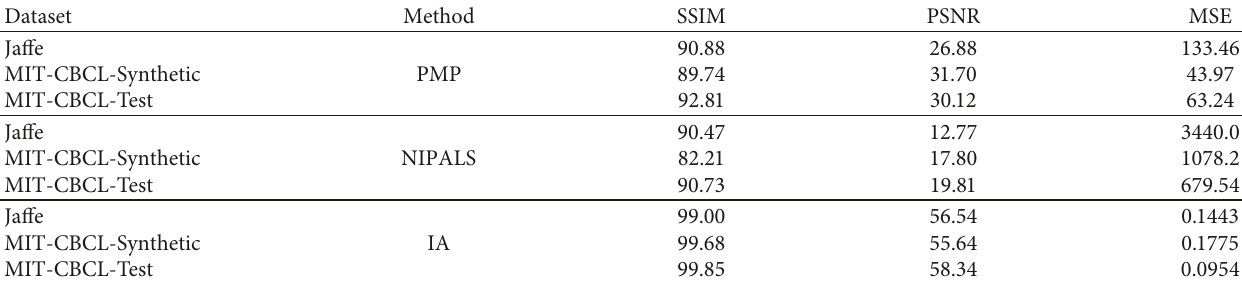
Table 1: Image quality assessment of imputation